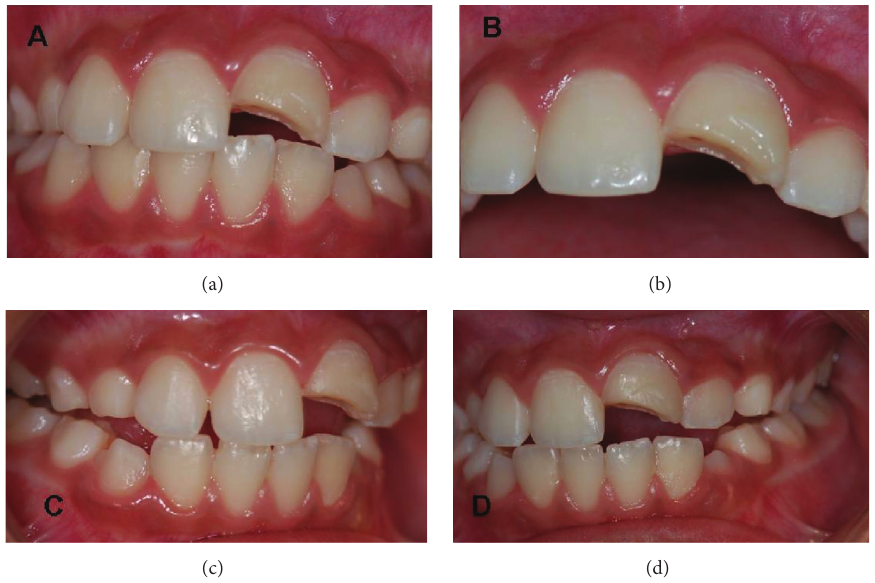
Figure 2: (a), (b) Initial clinical aspect, close-up. (c) and (d) Malocclusion in laterality. anterior vital teeth that require additional retention